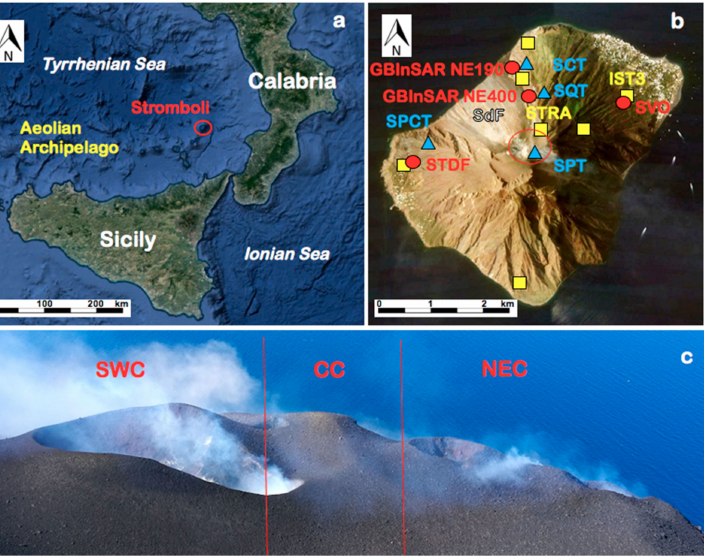
Figure 1. ( a ) Google map of southern Italy, with the red circle showing the position of Stromboli volcano, at the NE end of the Aeolian Archipelago. ( b ) Stromboli island with the position and labels of the monitoring instruments used in this study. The blue triangles are the monitoring cameras, with SPT being the thermal camera located at Il Pizzo Sopra La Fossa viewpoint. The SCV camera is located in the same place as SCT, and the SQV camera is in the same place as SQT; the red circles are the GBInSARs, the tilt (STDF) and strainmeter (SVO) stations; the yellow squares are the seismic stations. The empty red circle outlines the position of the summit craters displayed in frame c. SdF = Sciara del Fuoco slope. ( c ) View from South and from Il Pizzo Sopra La Fossa viewpoint of Stromboli summit craters; photo taken on 21 February 2020, showing the names of the active crater areas. NEC = NE Crater zone; CC = Central Crater zone; SWC = SW Crater zone. The field of view is about 300 m wide. Photo courtesy of F. Ciancitto,